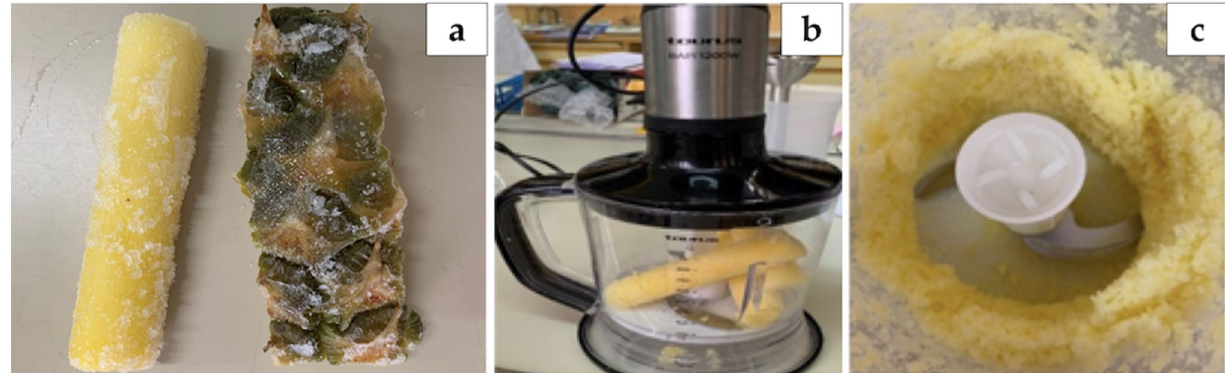
Figure 1. ( a ) Frozen core and peel pineapple by-products used in this study; ( b ) crushing process of the samples with the domestic blender; ( c ) crushed and homogenized pineapple by-products core samples.